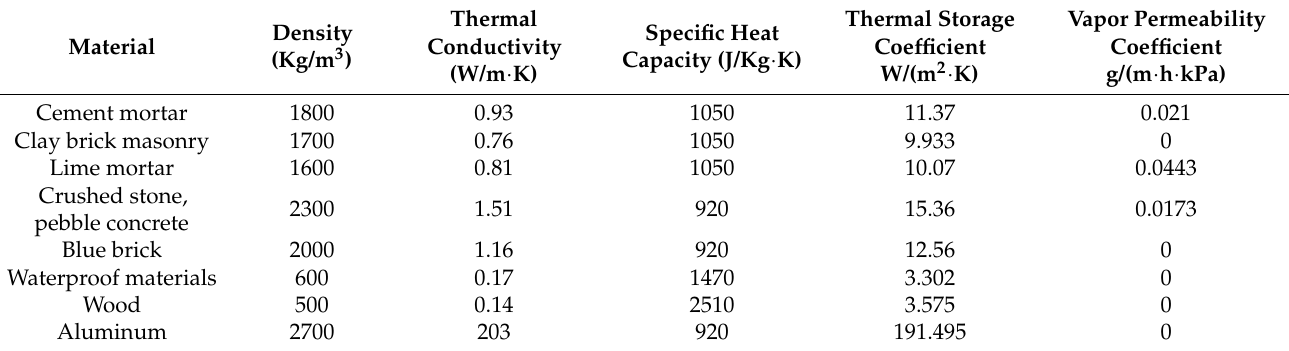
Table 2. Properties of residential